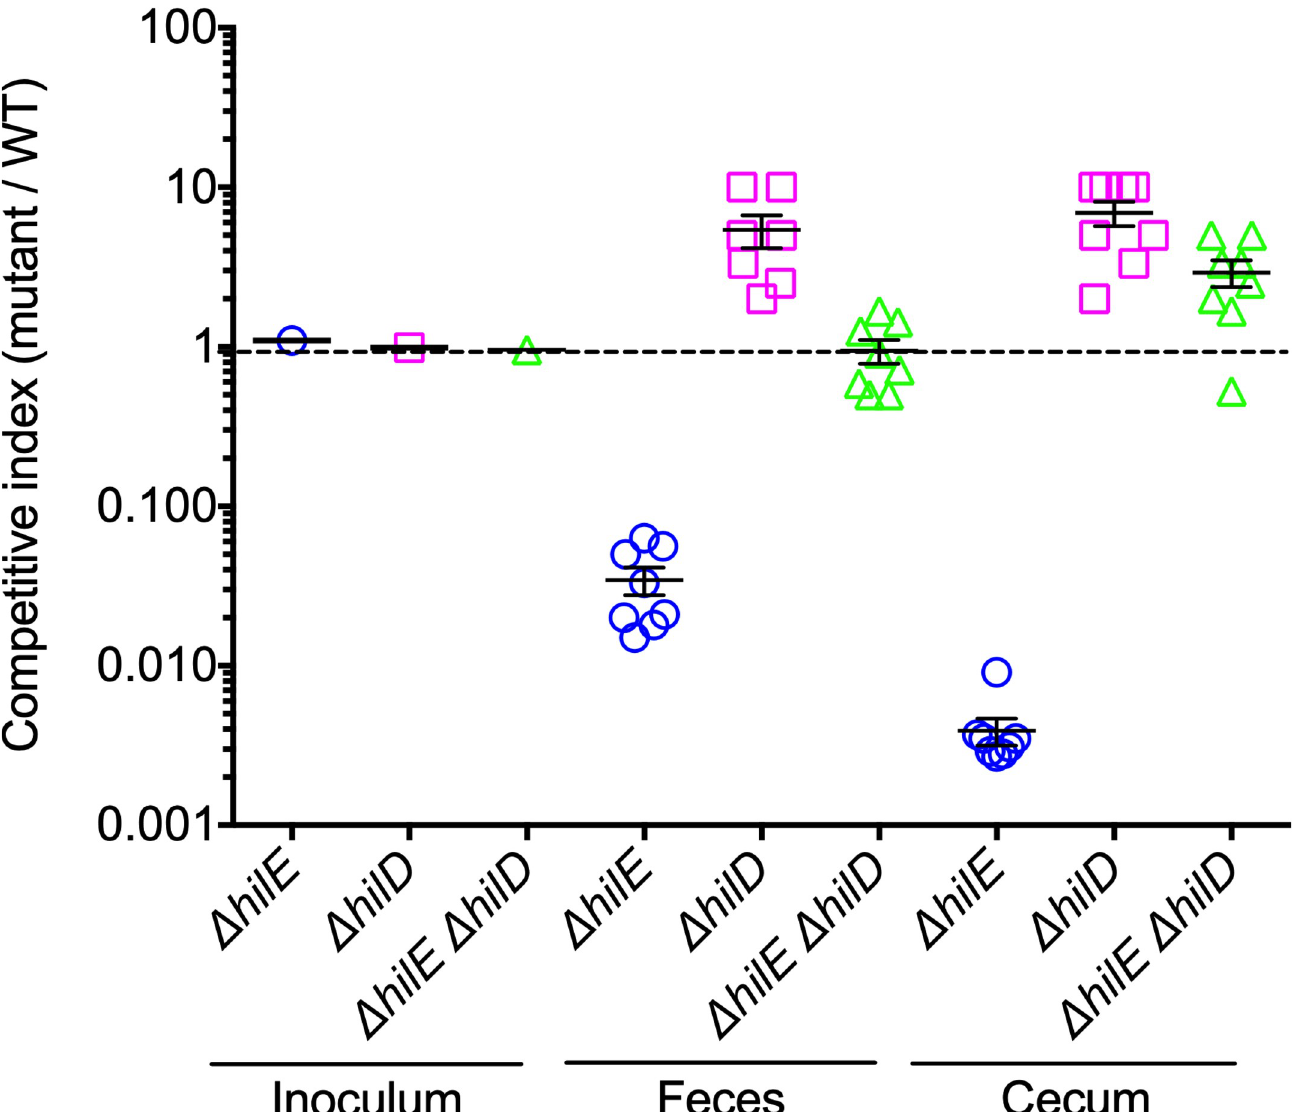
Fig 7. HilE is required for the intestinal colonization of mice by S . Typhimurium. Groups of eight streptomycin-pretreated mice were orally inoculated with a mixed bacterial suspension containing an equal amount of CFUs (0.5 x 10 6 ) of the WT S . Typhimurium strain and the respective mutant (WT + Δ hilE , WT + Δ hilD or WT + Δ hilE Δ hilD ). At 3 days post-infection, CFUs from feces and cecum were counted for each strain and a Competitive Index (CI; CFUs mutant / CFUs WT) was obtained. A CI was also determined for the respective inoculum. Data for each mouse or inoculum were log-transformed and plotted. CIs are indicated as follows: WT/ Δ hilE , blue circles; WT/ Δ hilD , pink squares; and WT/ Δ hilE Δ hilD , green triangles. Bars denote the standard error of the mean for each experimental group. CI of 1.0, represented by a horizontal dotted line, indicates that the two strains (WT and mutant) were present in equivalent